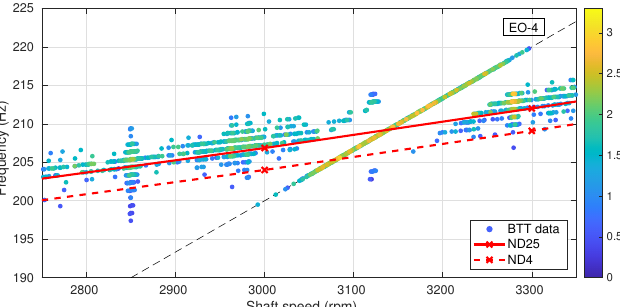
Figure 3. Blade displacement from BTT for the tuned configuration with an EO4